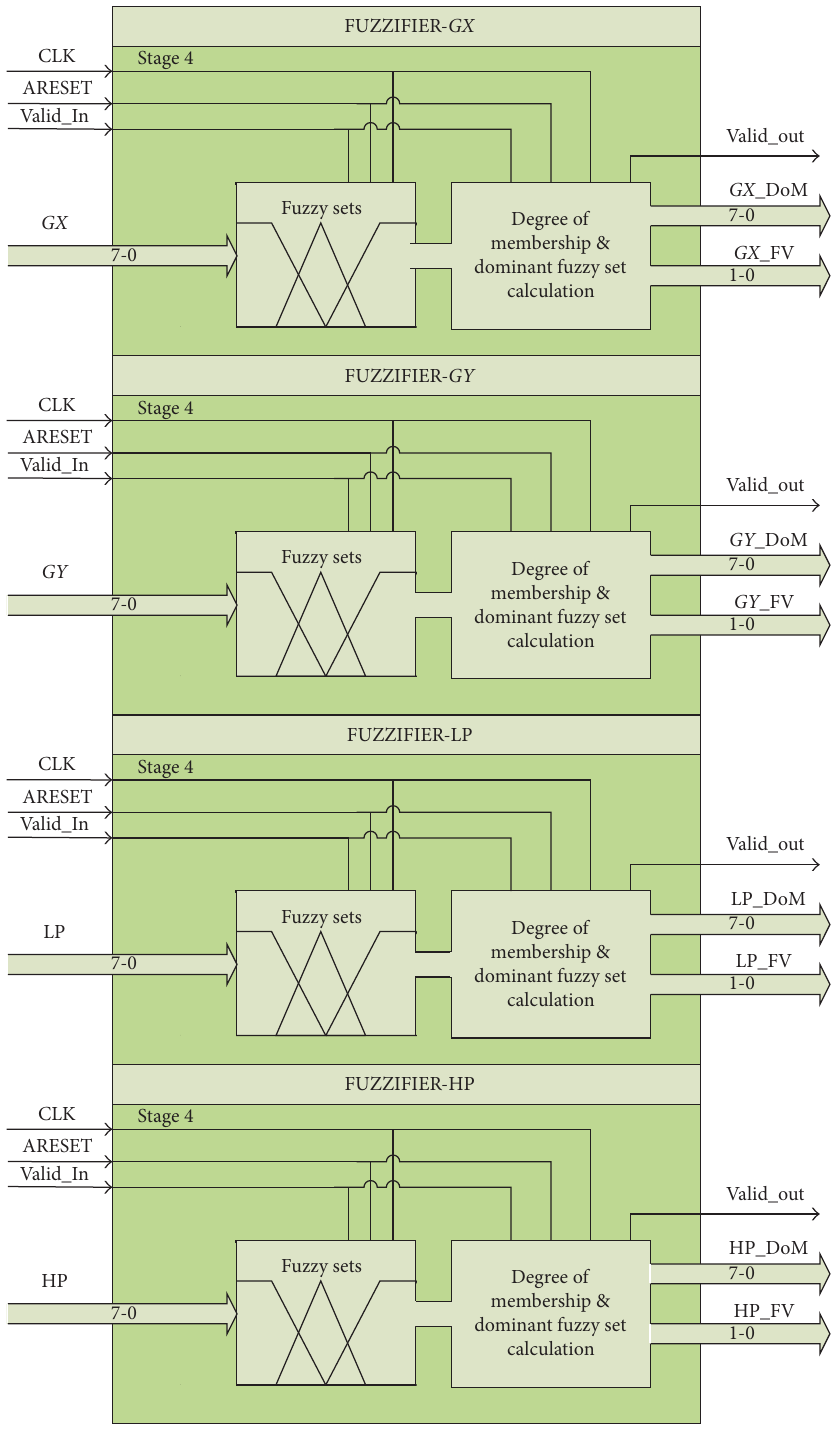
Figure 4: Fuzzification unit functional block